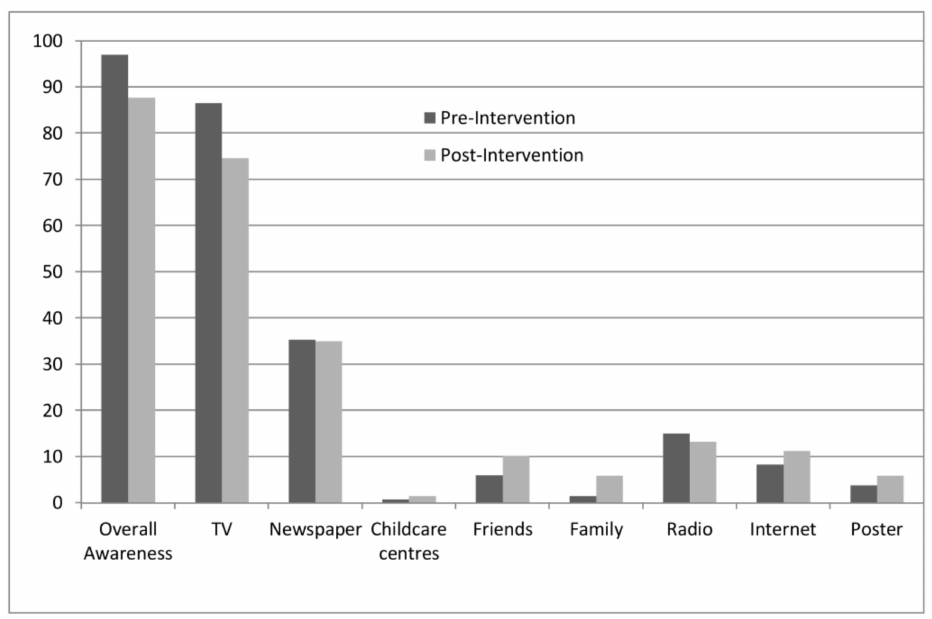
Figure 3. LSVRO Awareness at pre-intervention and